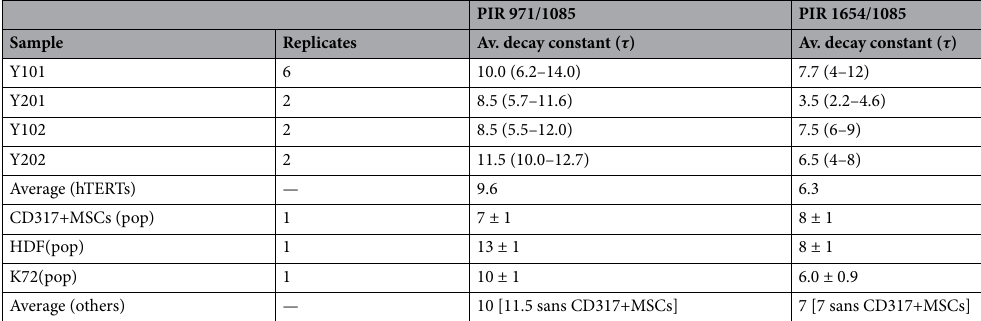
Table 2. Average decay constants ( τ ) obtained for the 971/1085 and 1654/1085 PIRs for the different cell populations analysed, together with the number of experiments performed. These summarised results have been extracted from Figs. S15–S20 and Tables S10–S17. A smaller τ represents a more “rapid decay” of the %SE. For the hTERT MSC-lines (Y101, Y201, Y102 and Y202), the range of τ values are shown in the brackets. For the other cell types, the uncertainty corresponds to the standard deviation of the exponential fitting since these experiments were performed only once. As the CD317+MSCs were sorted by FACS, the average (Av.) decay rates were also shown for the primaries with their results